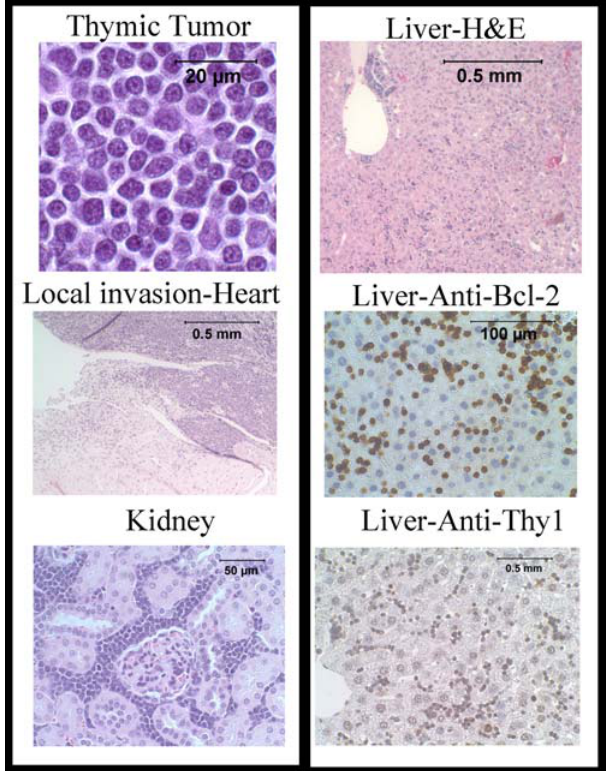
Figure 8. Tumors from p27 2 / 2 Lck-Bcl-2 mice are aggressive T cell lymphoblastic lymphomas. Histological analysis of the thoracic tumors from the p27 2 / 2 Lck-Bcl-2 mice is shown as indicated. H&E staining shows a characteristic lymphoblastic lymphoma (Top left) that were frequently locally invasive (Heart) and involved distant organs such as the kidney and liver. Immunohistochemistry staining of the liver confirms the tumors are of T cell origin (Thy1 positive) and retain expression of human BCL-2.